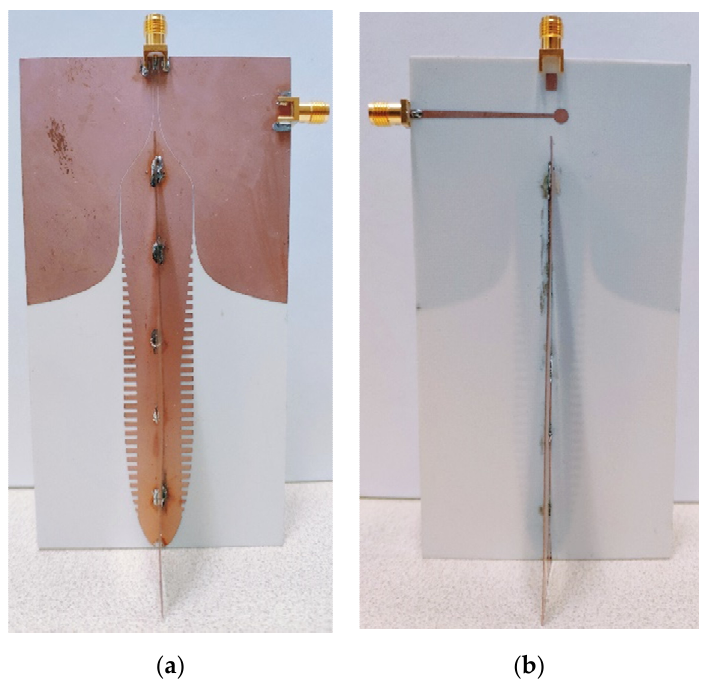
Figure 9. The fabricated antenna. ( a ) Front view, ( b ) back view. Table 1. Dimensions of the proposed antenna (mm).